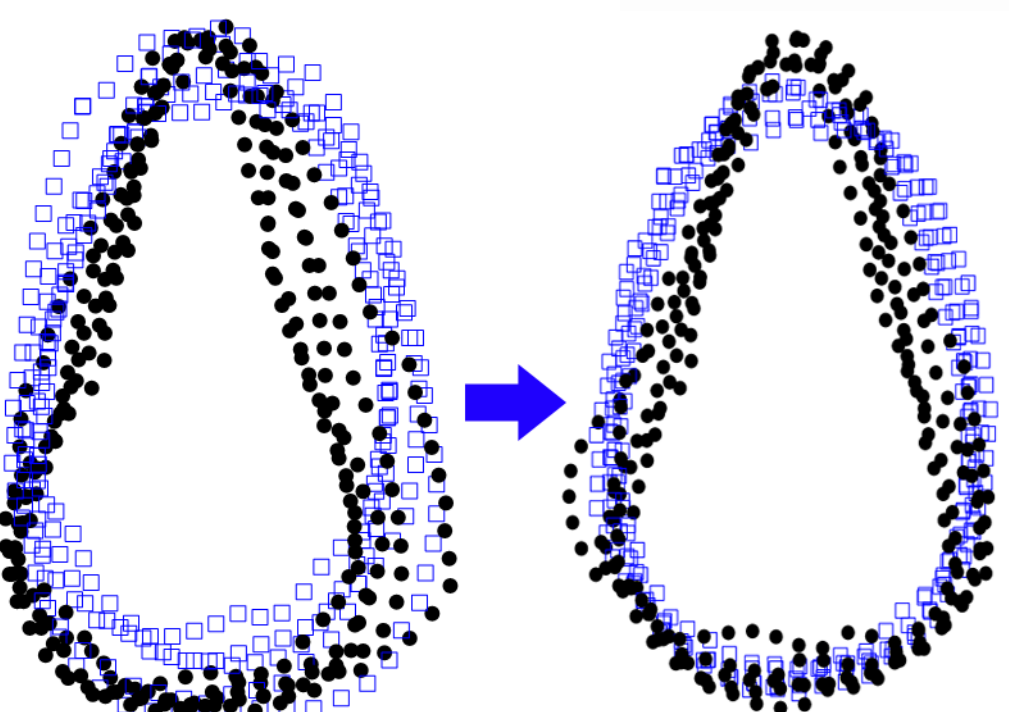
Figure 4. Procrustes superimposition process removes size, translates, and rotates ( i.e. , orientation) the outlines from the original shape data. Original outline data (left) vs. Procrustes aligned data (right). These images correspond with the 60 equally spaced points outlines of handaxes from the Swanscombe (black dots) and Boxgrove (blue